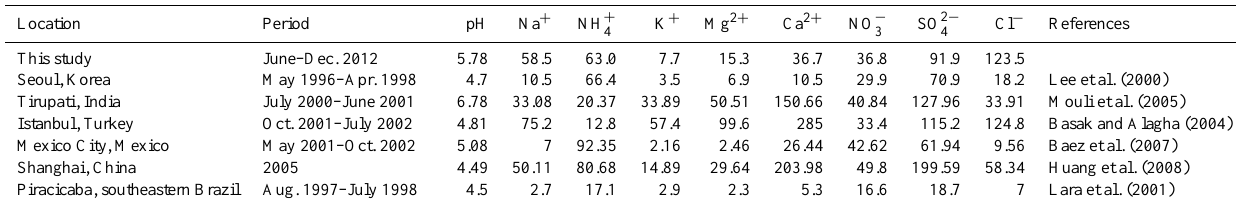
Table 2. Comparison between the VWMC of major ions (µeqL − 1 ) in precipitation in Gwangju and at other sites. Location Period